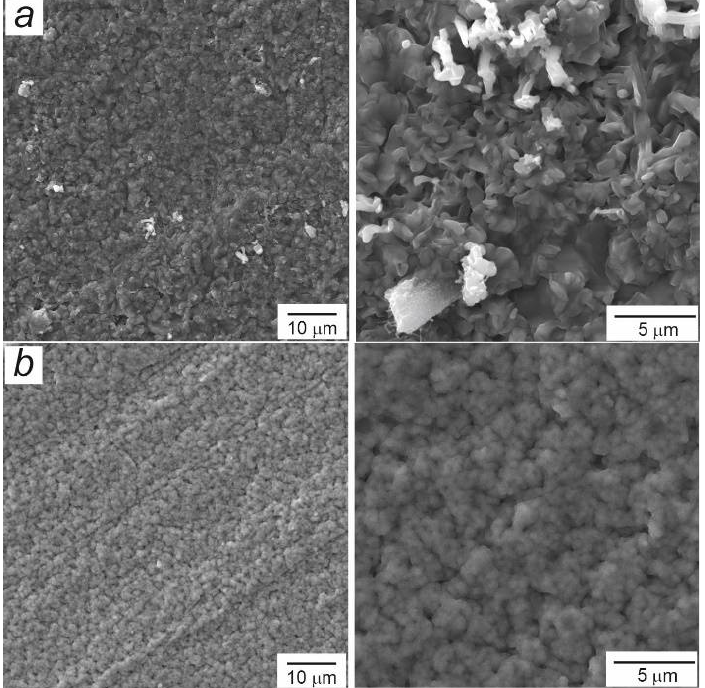
Figure 5. SEM images of surface morphology: coating synthesized in an argon atmosphere ( a ), coating synthesized in a nitrogen atmosphere ( b ).